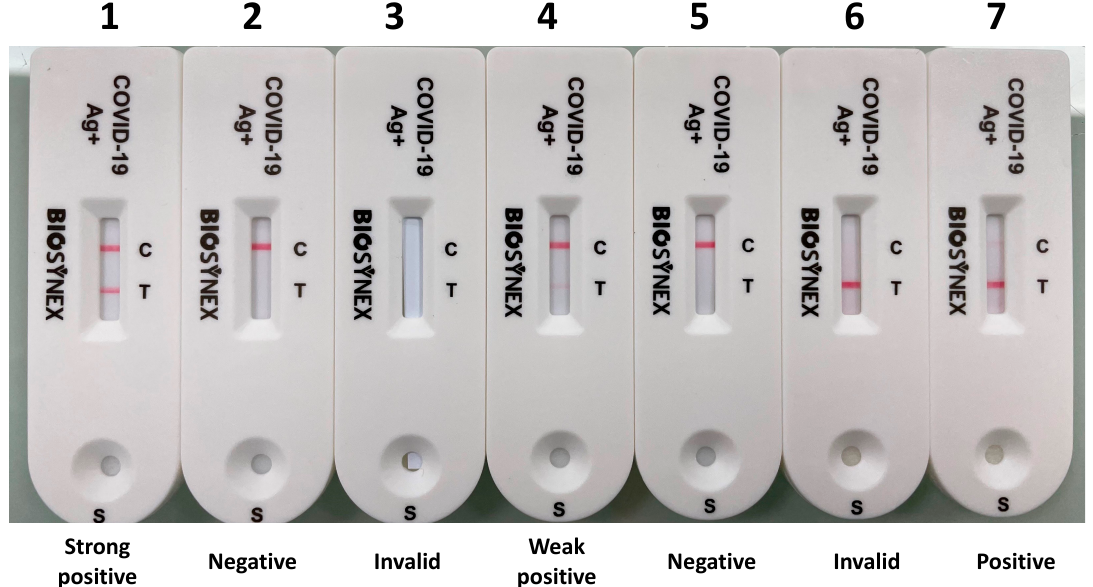
Figure 2. Panel of 7 BIOSYNEX Antigen Self-Test COVID-19 Ag+ (Biosynex Swiss SA) cassettes, including 3 positive tests (strong positive: n°1; weak positive: n°4; and positive: n°7), 2 negative tests (n°2 and n°5) and 2 invalid tests (n°3 and n°6). Each participant drew and interpreted five of the seven tests and the results were recorded by the observer.